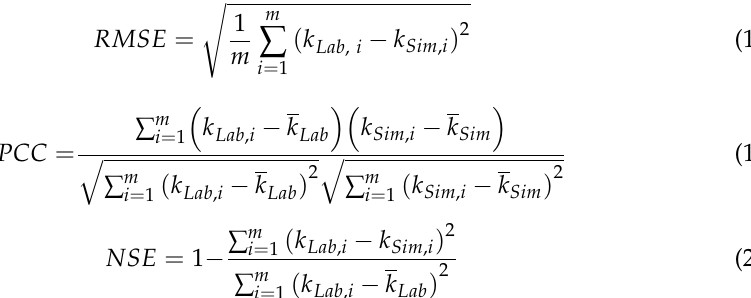
( d ) Figure 7. Particle size distributions of the gravel. ( a ) D Ⅰ , size range was 2 – 5 mm. ( b ) D Ⅱ , size range was 5 – 10 mm. ( c ) D Ⅲ , size range was 10 – 20 mm. ( d ) D1, D2, and D3 particle size distributions in the laboratory test.